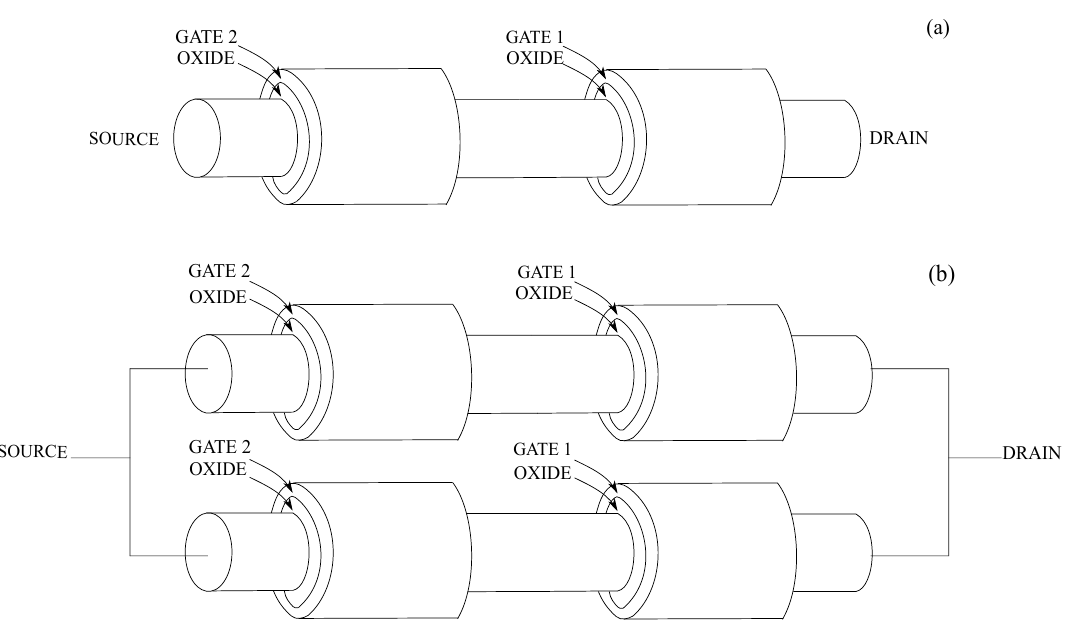
Figure 7. 3D Structure of ( a ) twin gate single channel GAAFET, ( b ) twin gate double channel GAAFET.